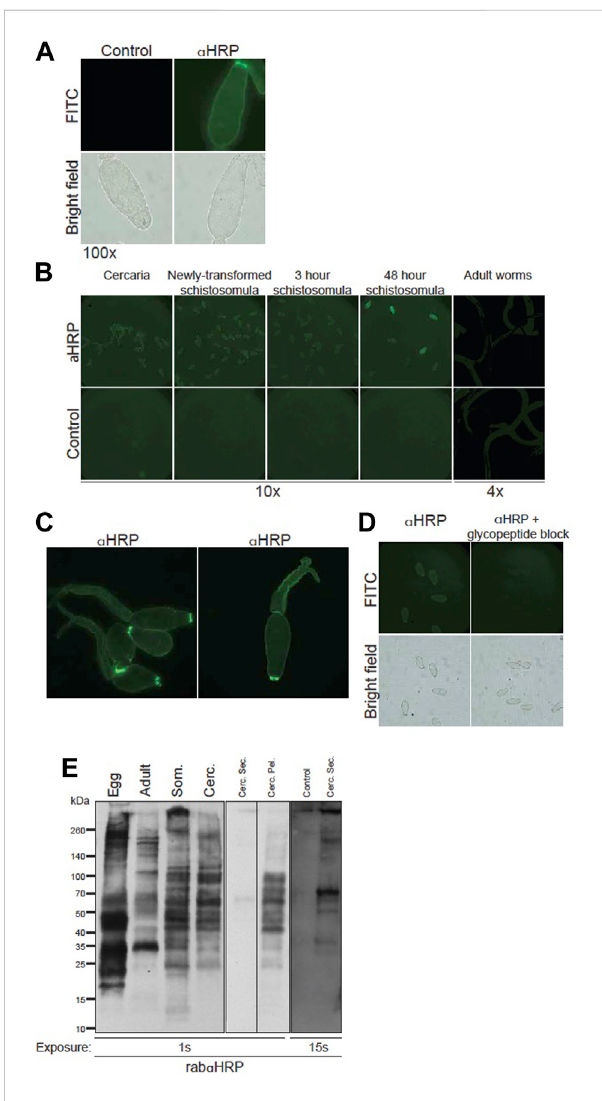
FIGURE 4 Core xylose/core fucose expressed on surface and secretions of S. mansoni larval life stages. (A) Fixed S. mansoni cercaria stained with 100 μ g/mL anti-HRP or control (normal rabbit IgG), anti-rabbit- Alexa488, mounted on slides and visualized at 100x (exposure time207.8 ms,FITC539.4 ms). (B) S.mansoni cercaria, invitro isolated schistosomula, and murine-isolated adult worms stained with rabbit anti-HRP or control (normal rabbit IgG) and visualized in 96-well plates; larvae imaged at 10x (exp time 1.051 s, FITC 490.3 ms), adults imaged at 4x (exp time 6.115 s, FITC 717.9 ms). (C) Cercaria stained with anti-HRP and imaged at 20x using deconvolution microscopy. (D) 3 h schistosomula stained with anti-HRP, (left), or anti-HRP pre- incubated with HRP glycopeptides (right) and imaged at 20x (exp time 1.051 s, FITC 490.3 ms). (E) Westernblot ofrabbit anti-HRP staining: S. mansoni soluble egg antigen (Egg), RIPA extracts of adult worms (Adult), 3 h schistosomula (Som) and whole cercaria (Cerc) each with 8 μ g loaded per well (left panel); Concentrated supernatant of cercarial secretions (Cerc. Sec., 1.4 μ g), secretion-depleted cercarial pellet (Cerc. Pel., 6.7 μ g) (middle panel); aquarium water concentrate as negative control (control), cercarial secretions (1.4 μ g) and secretion-depleted cercarial pellet (6.7 μ g) (right panel) at indicated exposure